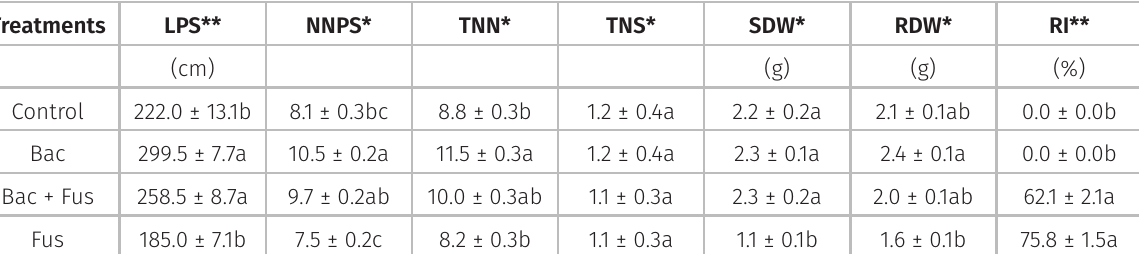
Table III. Morphophysiological responses in cuttings of grapevine rootstock SO4: length of the primary shoot (LPS), number of nodes in the primary shoot (NNPS), total number of nodes (TNN), total number of shoots (TNS), shoot dry weight (SDW), root dry weight (RDW) and frequency of F. oxysporum re-isolation (RI) in four treatments: